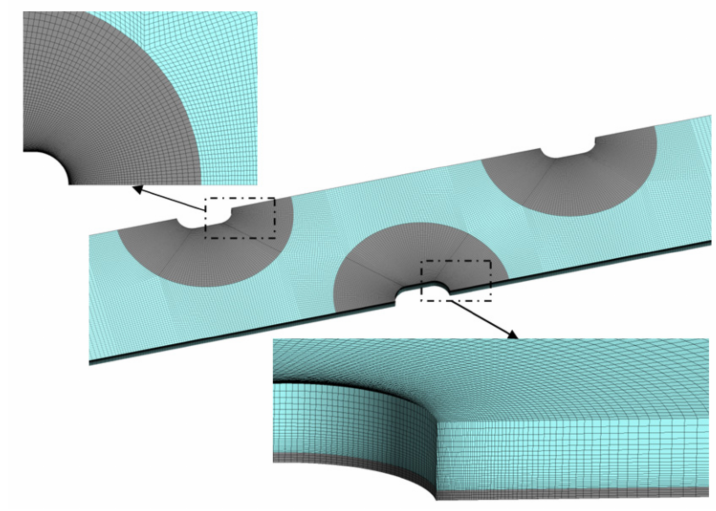
Figure 4. Grid structure used in